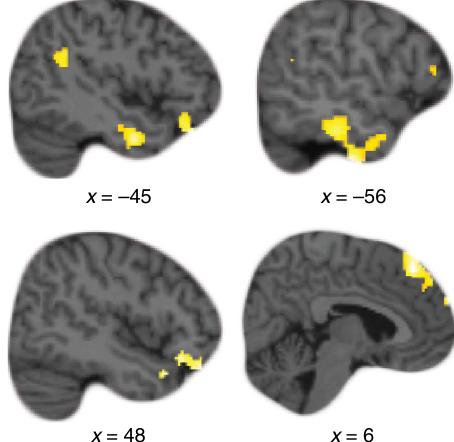
Fig. 3 Functional connectivity with the left anterior hippocampus. Regions demonstrating signi fi cantly higher functional connectivity (PPI) with the left anterior hippocampus for prior-knowledge (PK) pairs compared to no-prior- knowledge (n-PK) pairs during associative learning (see also Supplementary Table 1). N =